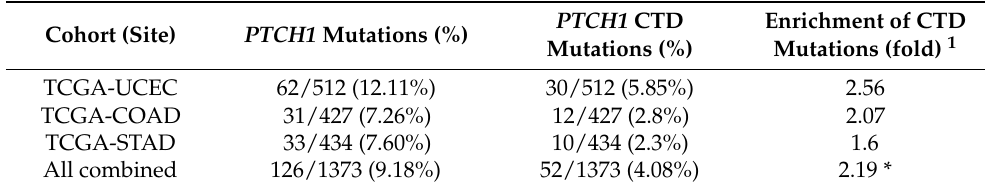
Table 1. Frequency of total and CTD-specific PTCH1 mutations in three cancer sites according to the TCGA